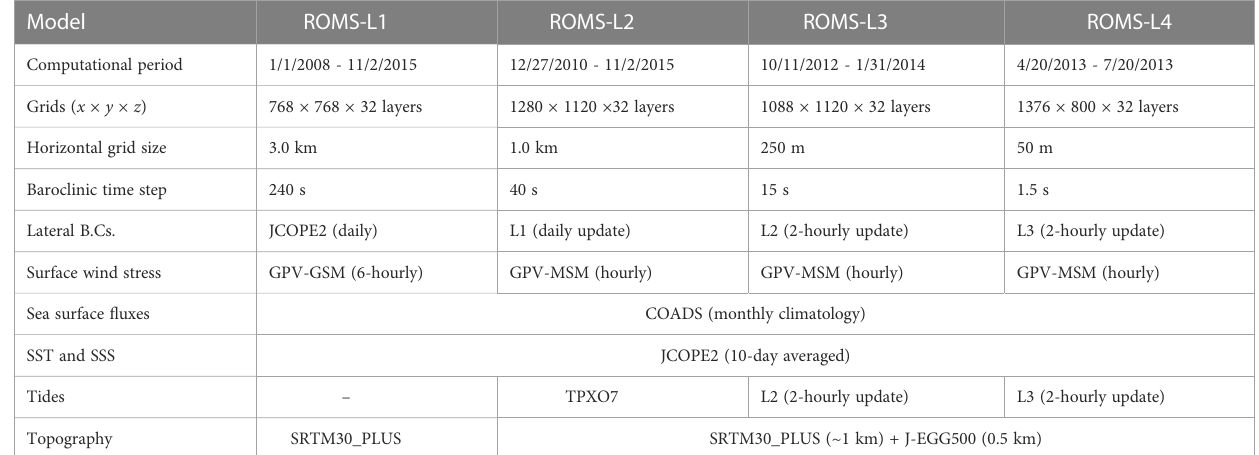
TABLE 1 Numerical con fi gurations for the suite of the quadruple nested ROMS